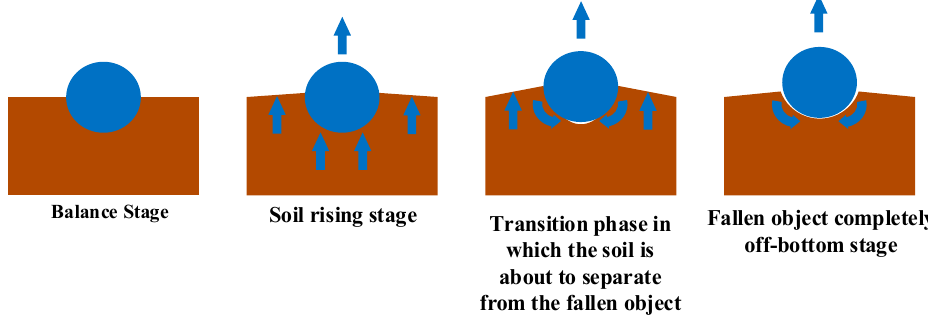
Figure 1. Schematic diagram of the fallen object and soil movement trend.